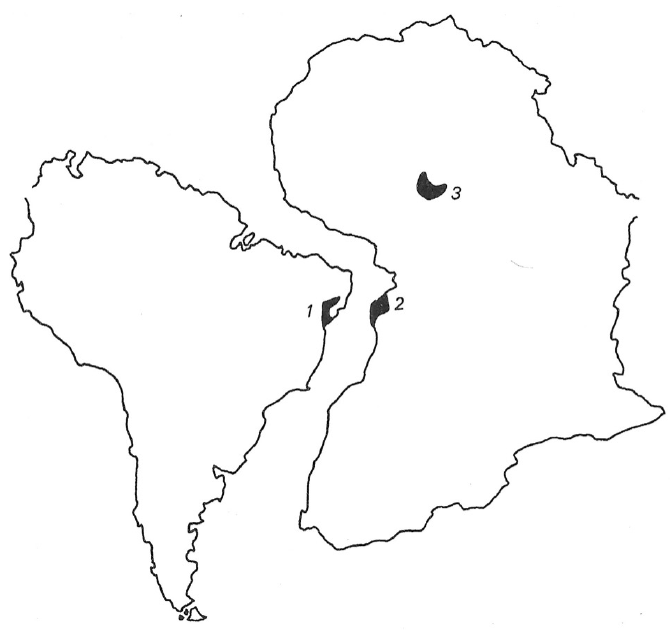
Figure 2. Map showing the three basins mentioned in the text: 1, Recôncavo (or Bahia) basin, Brazil. 2, Gabon basin, Gabon. 3, Tegama basin,